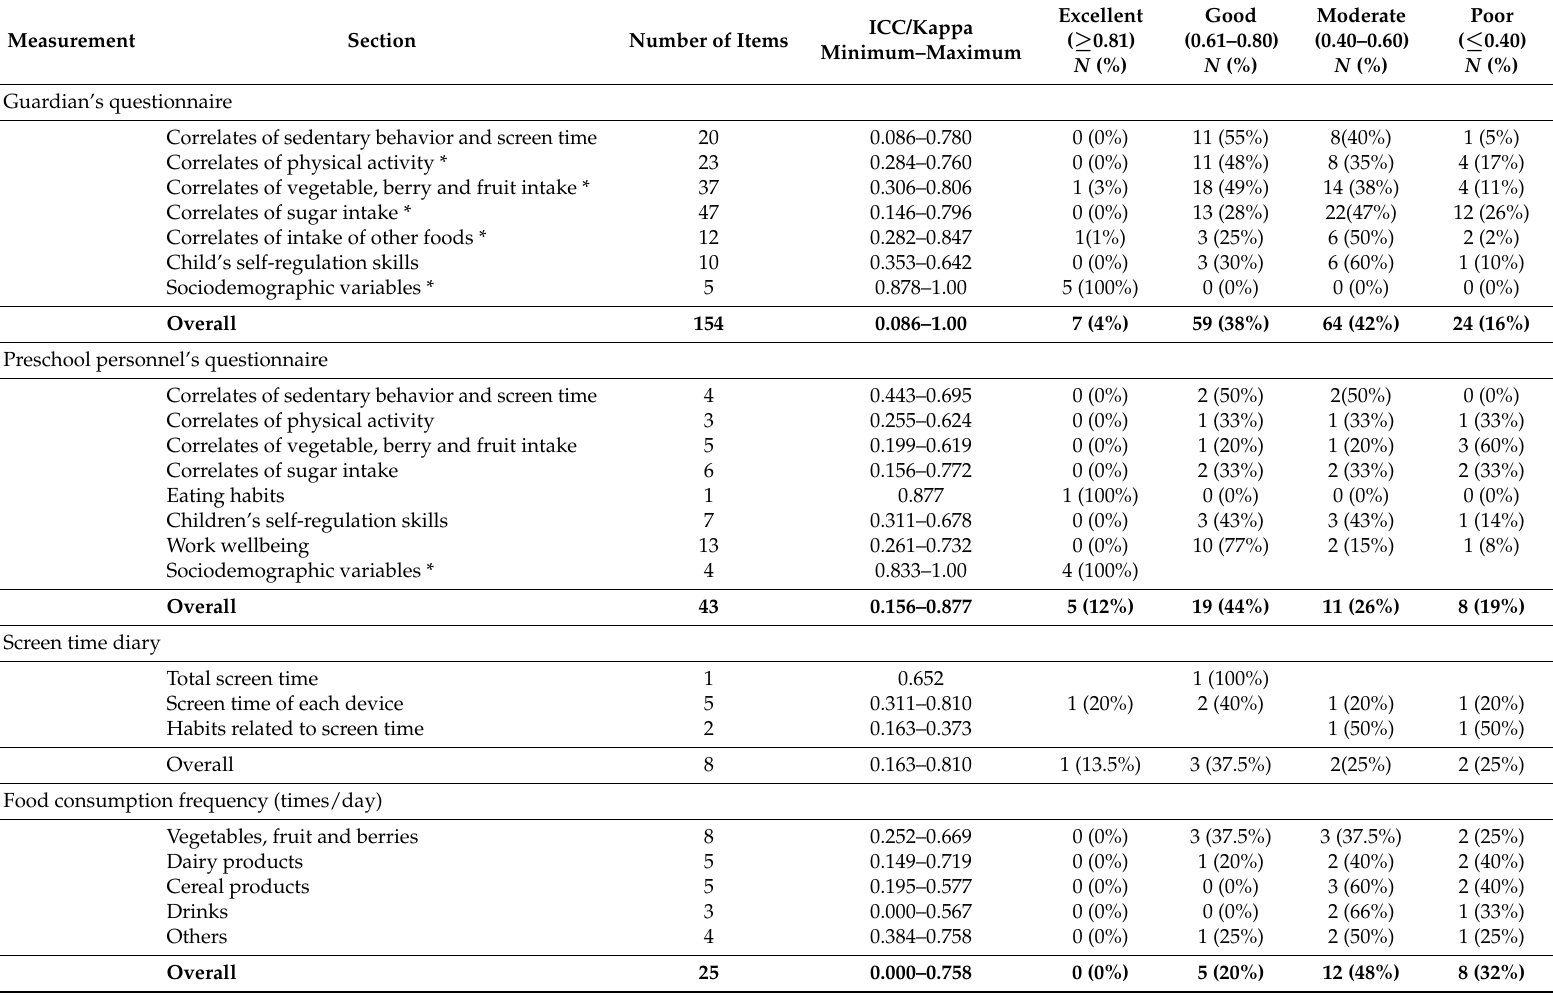
Table 2. Overview of the intraclass correlation coefficients (ICC) and kappa values for education, occupation and gender for the sections in the guardian questionnaire, preschool personnel’s questionnaire, screen time diary, and food frequency questionnaire in the DAGIS reproducibility sub-study in spring